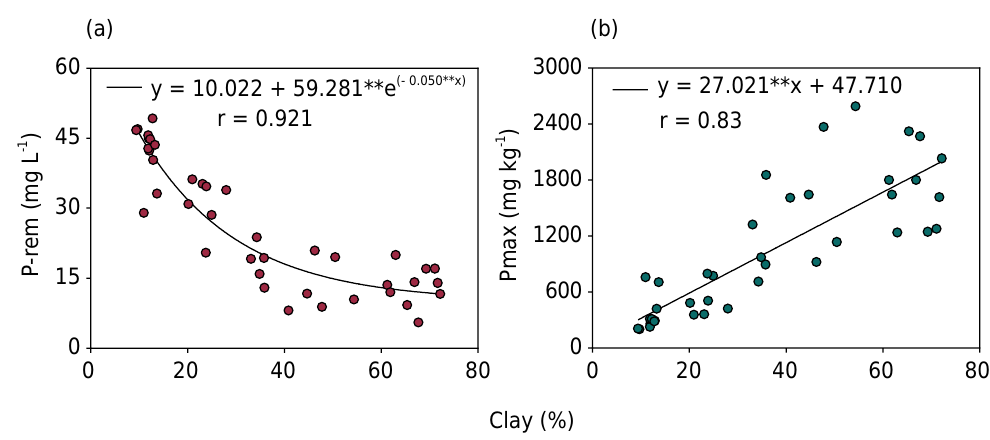
Figure 2. Relations between the content of clay (average between the two methods) to P-rem (a) and Pmax (b), for the 40 samples of soils collected in the state of Rio Grande do Sul,